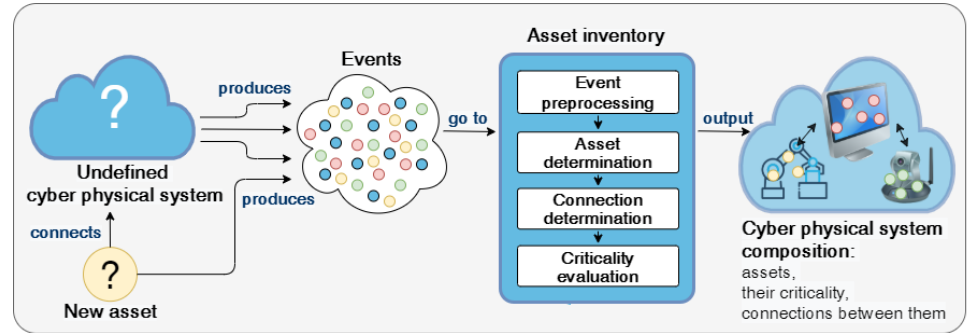
Figure 1. The common idea of the proposed approach to asset